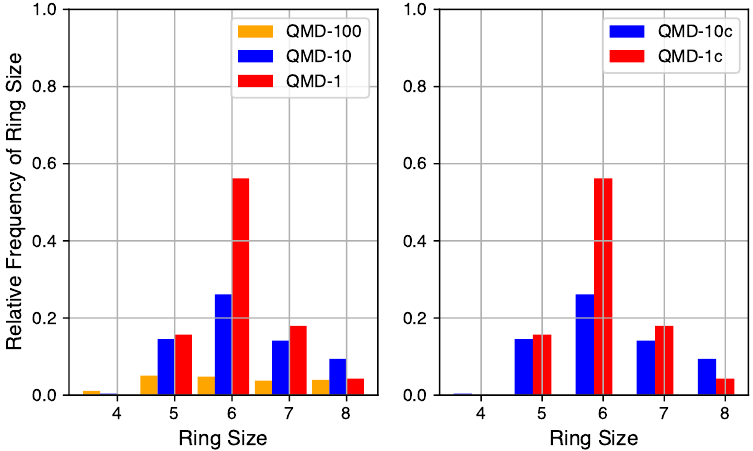
Figure 4. Ring size distributions of QMD-generated